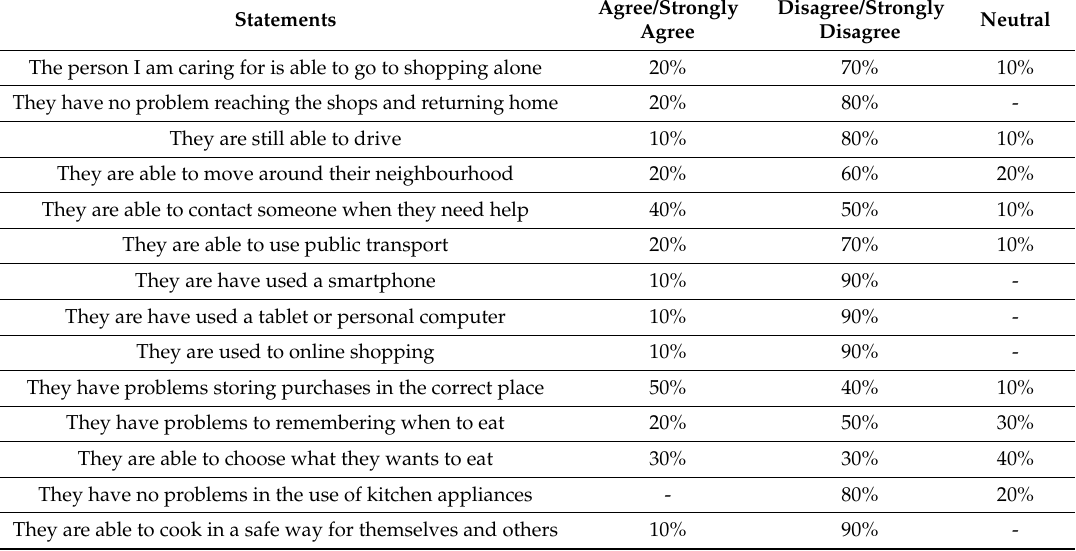
Table 2. Carer assessment of the everyday abilities of the person in their care ( n =